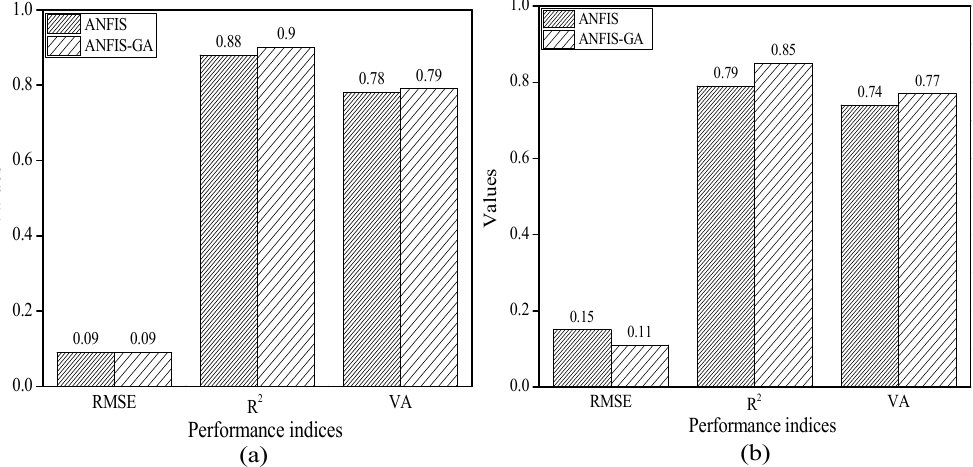
Figure 10. Performance of all measured and predicted database for the ANFIS-GA model.